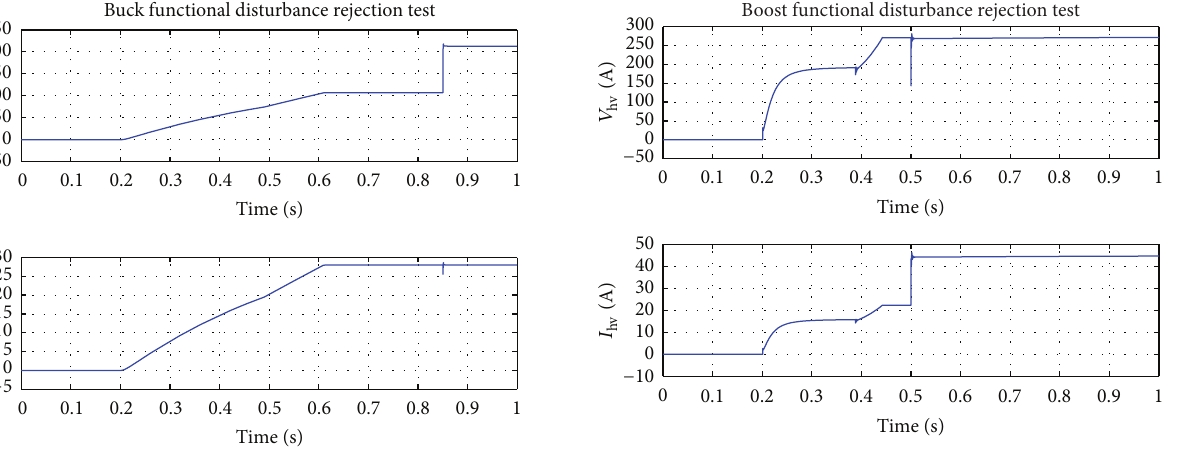
Figure 13: Buck mode test for functional robustness test.